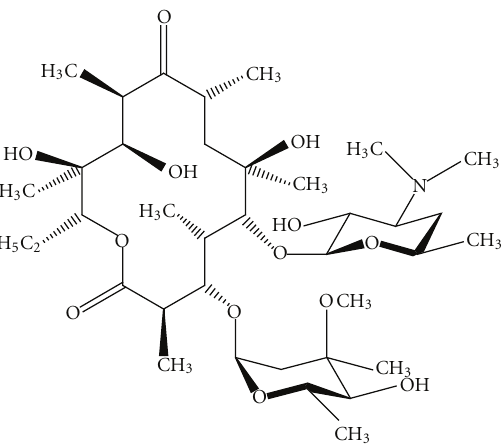
Figure 1: The molecular structure of erythromycin, the 14- membered prototype macrolide